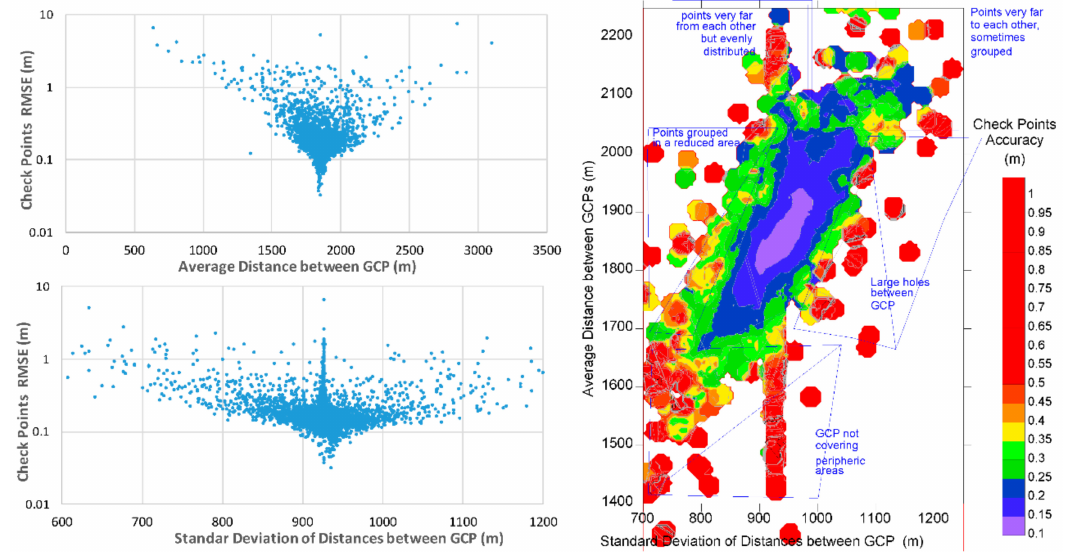
Figure 10. Accuracy measured at check points for the 3465 combinations versus the average distance between GCPs (top left), the standard deviation of distances (bottom left), and both variables